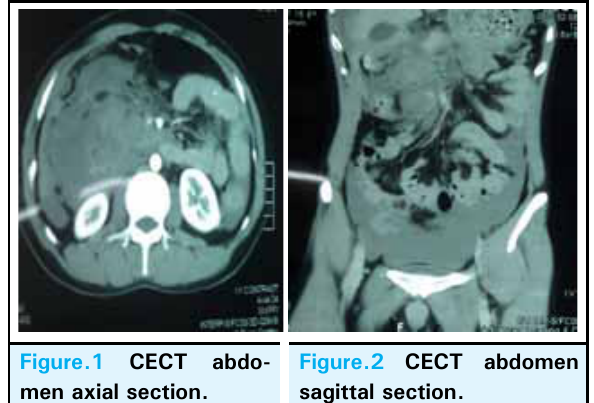
Figure.1 cEct abdo- men axial section.